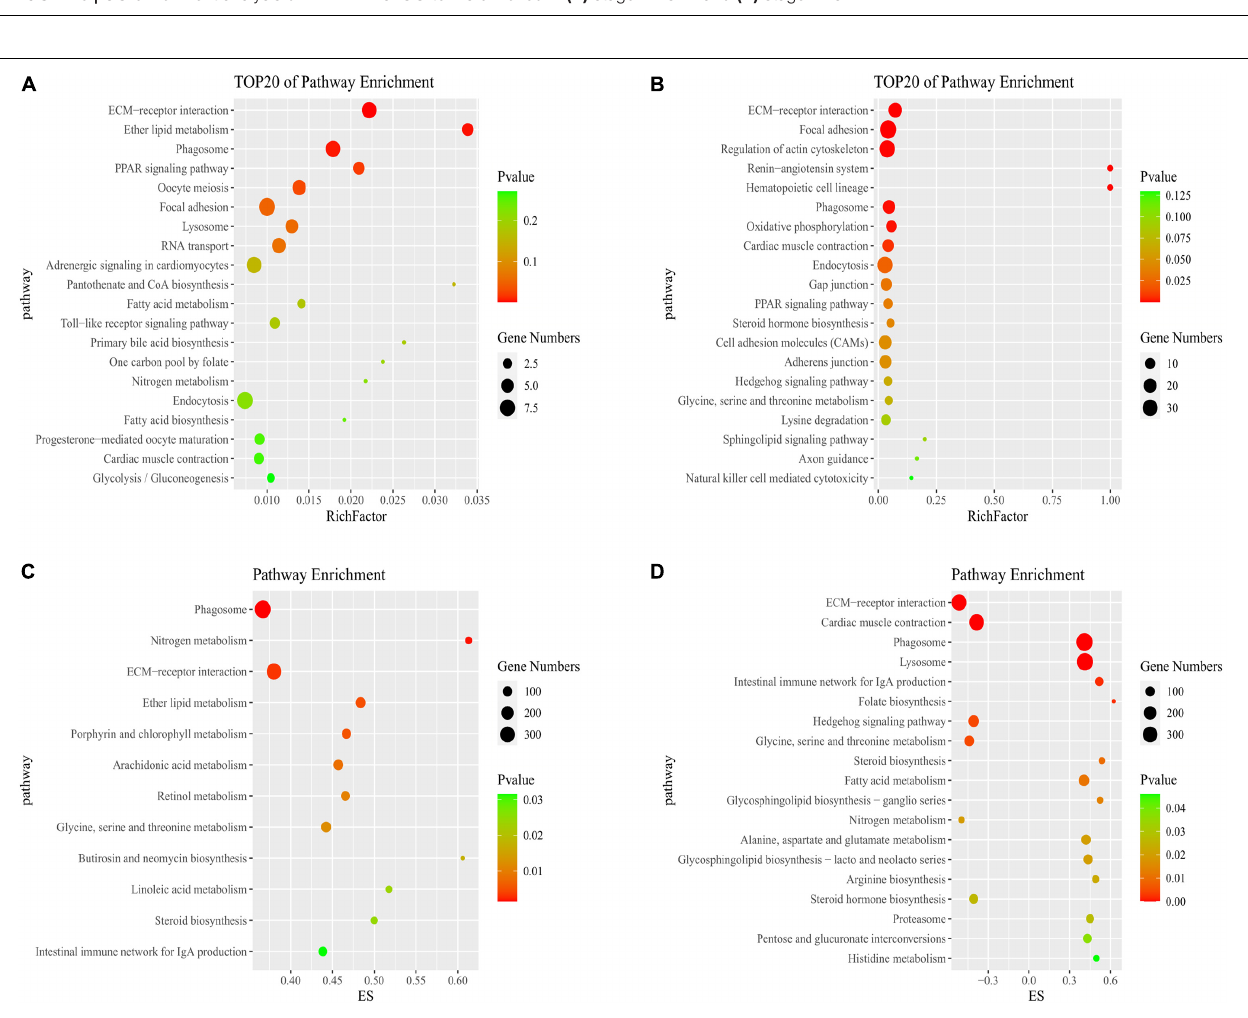
FIGURE 4 | Pathways enrichment analysis of DE mRNAs. KEGG pathway enriched in stage IV vs. V (A) and stage V vs. VI (B) . GSEA of KEGG pathway enriched in ovarian stage IV vs. V (C) and stage V vs. VI (D) .